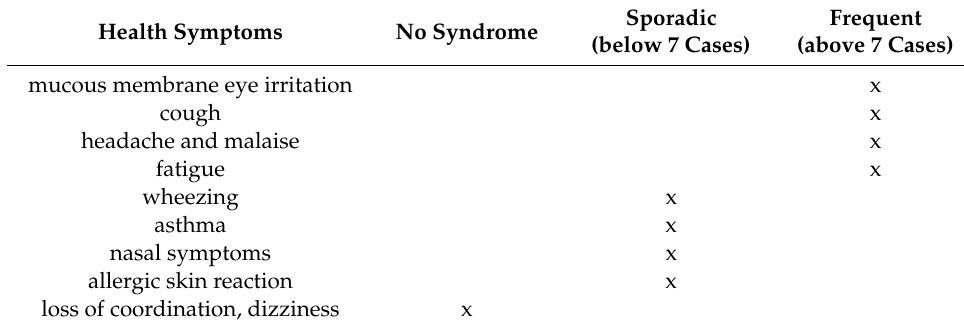
Table 4. List of health symptoms described by users of 15 residential buildings in which Xylamite was